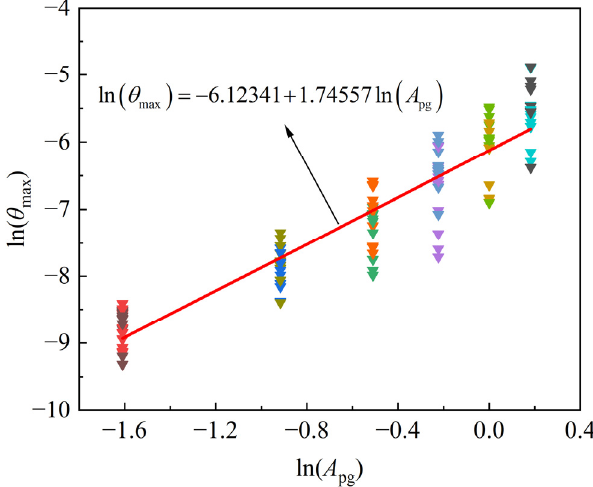
Figure 13. The probabilistic structure demand model.